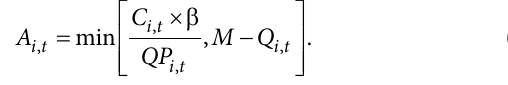
Table 4. Investment ratio coefficient and price